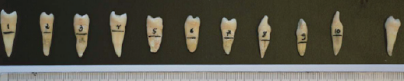
Figure 3: Monoradicular teeth cut 2–5 mm from CEJ.